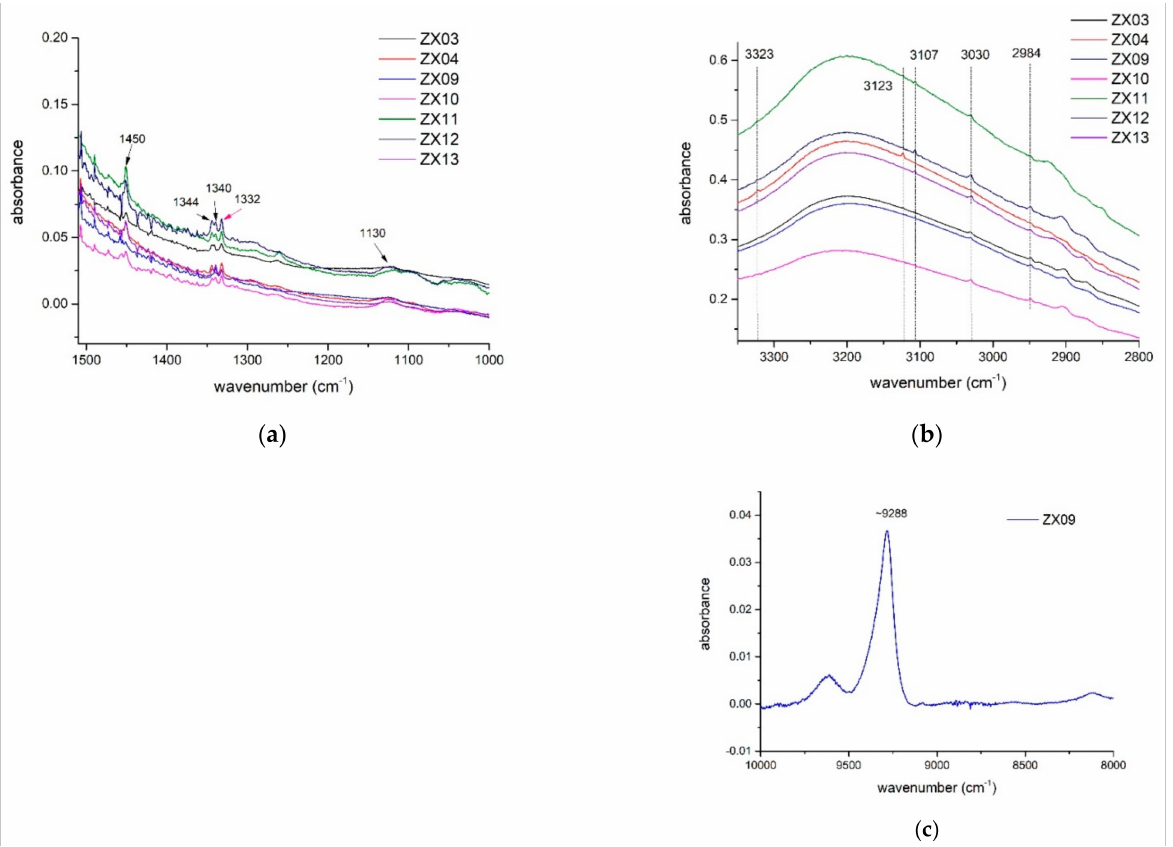
Figure 5. In the 1000–1500 cm − 1 region ( a ), the mid-infrared spectrum of these pink CVD synthetic diamonds revealed that they are type Ib with a very small concentration of isolated nitrogen. In the 2800–3400 cm − 1 region ( b ), these samples revealed 3123, 3107, and 3030 cm − 1 peaks due to hydrogen. In the near-infrared region of 8000–10,000 cm − 1 ( c ), a broad absorption band at the centre of ~9288 cm − 1 could be